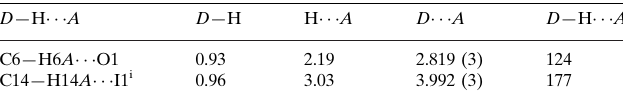
Bruker APEXII CCD area-detector diffractometer Absorption correction: multi-scan ( SADABS ; Bruker, 2005)